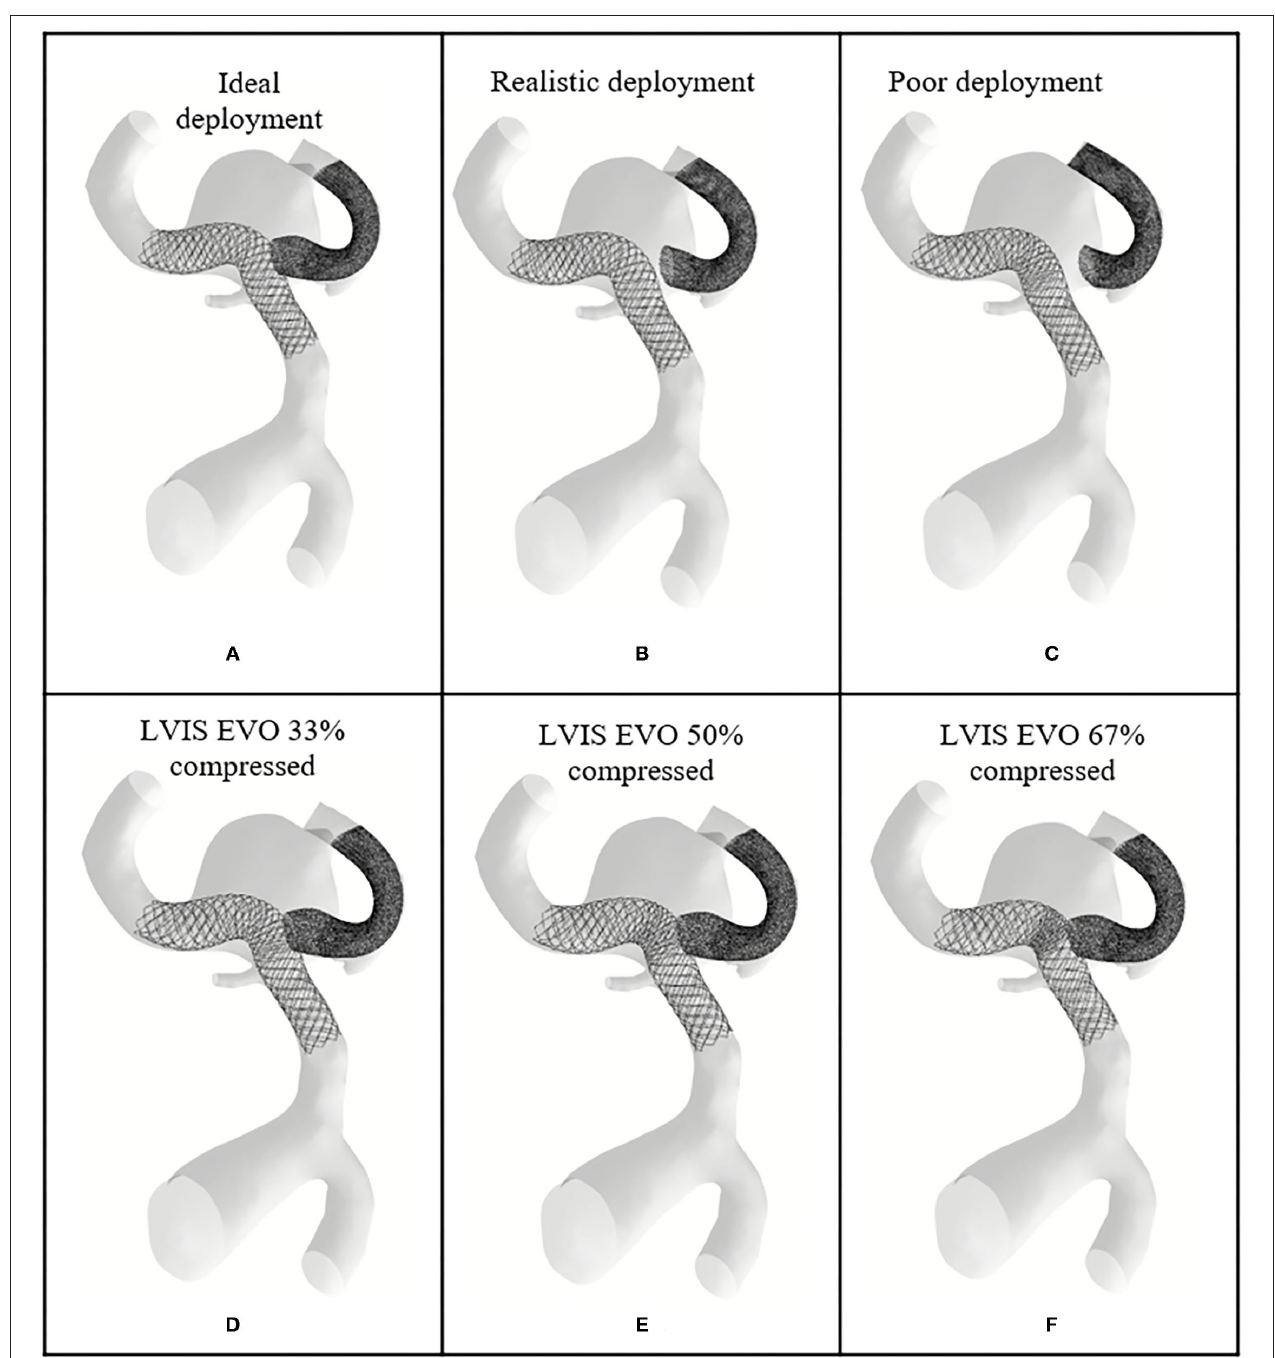
FIGURE 4 | Deployed device positions in WNBA I. (A) Ideal deployment of LVIS EVO in the side daughter vessel. (B) Realistic deployment of LVIS EVO in the side daughter vessel. (C) Poor deployment of LVIS EVO in the side daughter vessel. (D–F) The deployment of LVIS EVO with 33, 50, 67% compression rate in the mid third part of the devices.